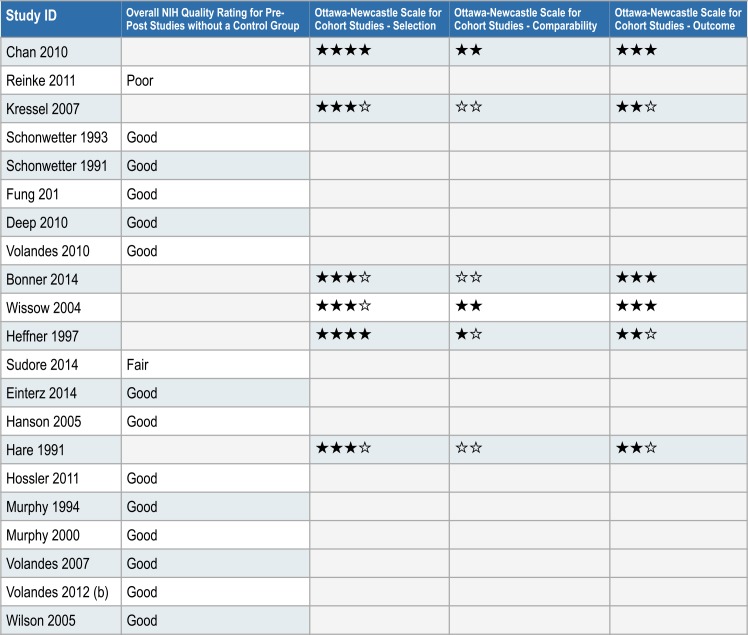
Risk of bias/quality assessments for observational studies.